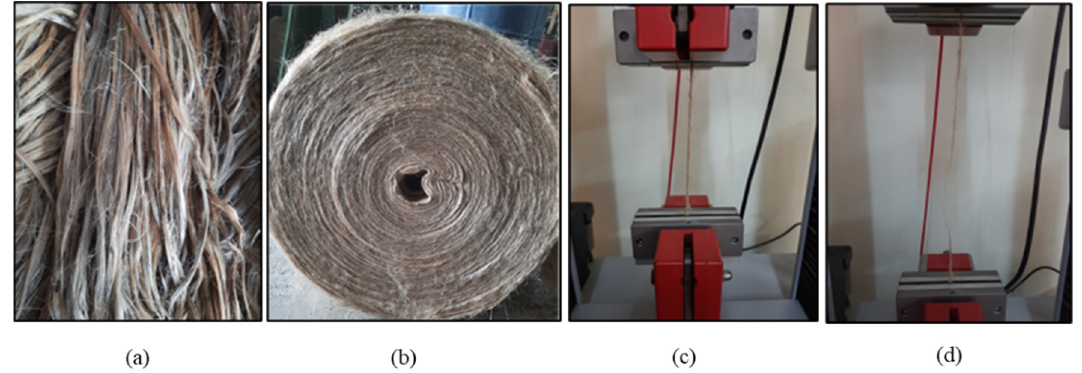
Figure 1. Experimental image; ( a ) raw jute fiber, ( b ) jute yarn sliver before spinning, ( c ) Testing of jute yarn using UTM machine and tearing of jute yarn after applying force ( d